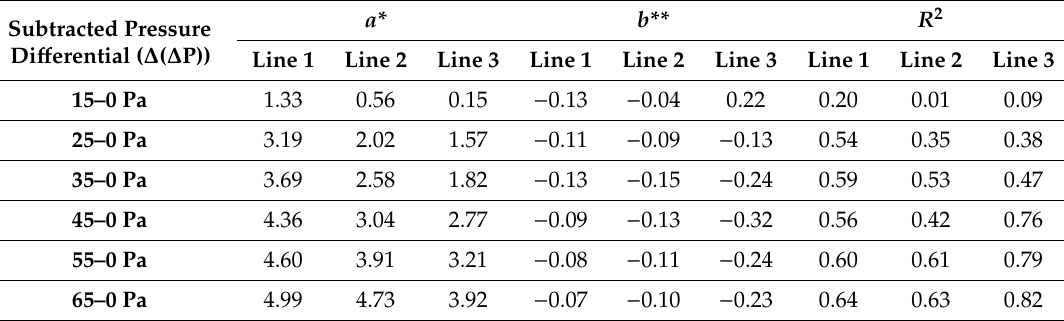
Table 6. Statistical parameters: Lines 1–3 ( y = ax b ).